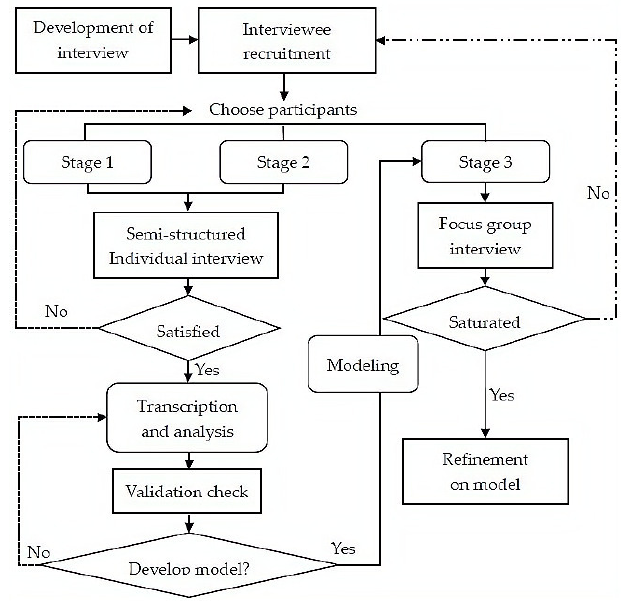
Figure 2. Flowchart of data collection and analysis based on grounded theory.